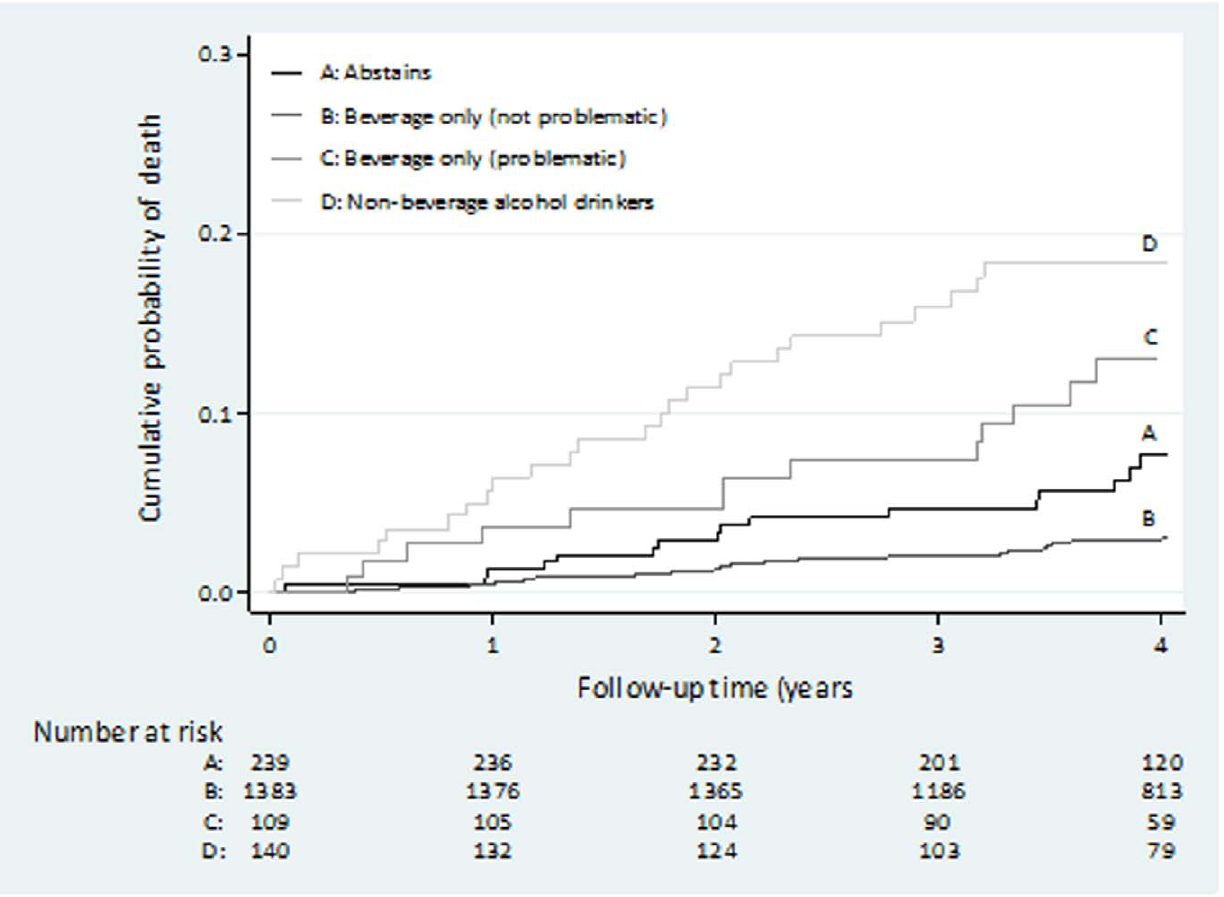
Figure 1. Kaplan-Meier plot of cumulative probability of death over four years follow-up by proxy reported type of alcohol drinking.